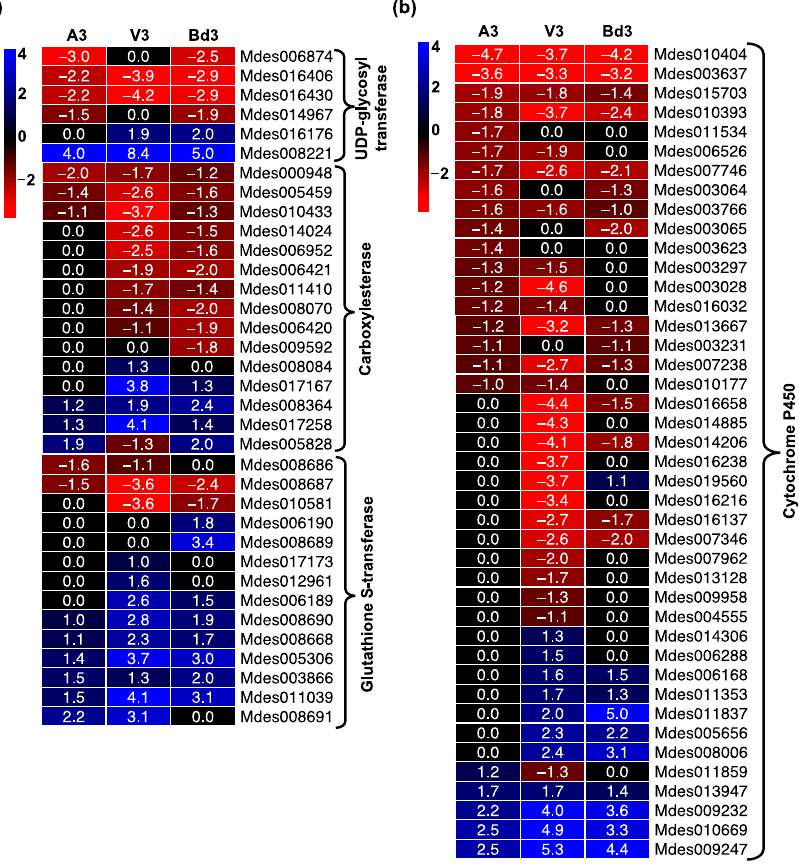
Figure 6. Regulation of detoxification enzymes in Hessian fly larvae 3 days after hatch (DAH). Heatmaps depict expression profiles of genes encoding detoxification enzymes in avirulent (A3), virulent (V3), and Bd3 larval transcriptomes. ( a ) Differential expression of genes encoding UDP- glycosyltransferase, carboxylesterase, and glutathione S-transferase enzymes. ( b ) Differential expression of genes encoding cytochrome P450 proteins. Log2 fold-change RNA-Seq values are shown within each cell of the heatmap. Blue represents up-regulated genes, and red represents the down-